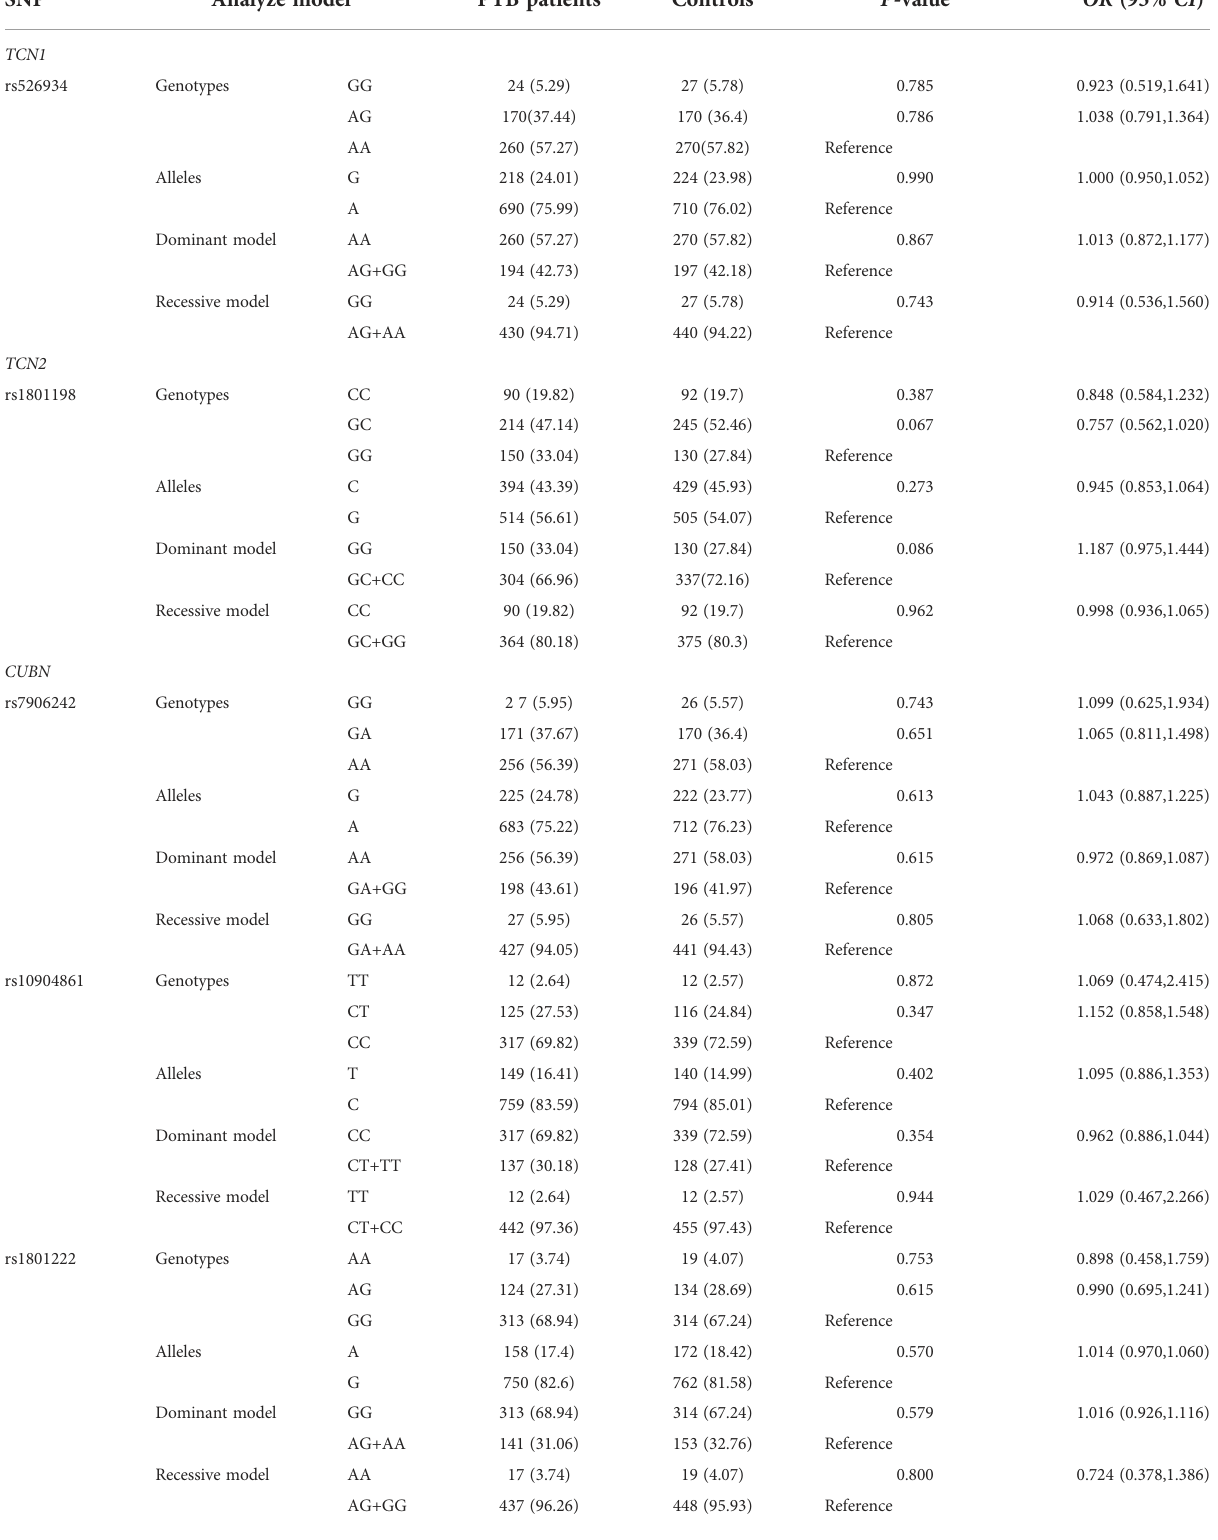
TABLE 1 Association of vitamin B12 metabolic genes polymorphisms with PTB